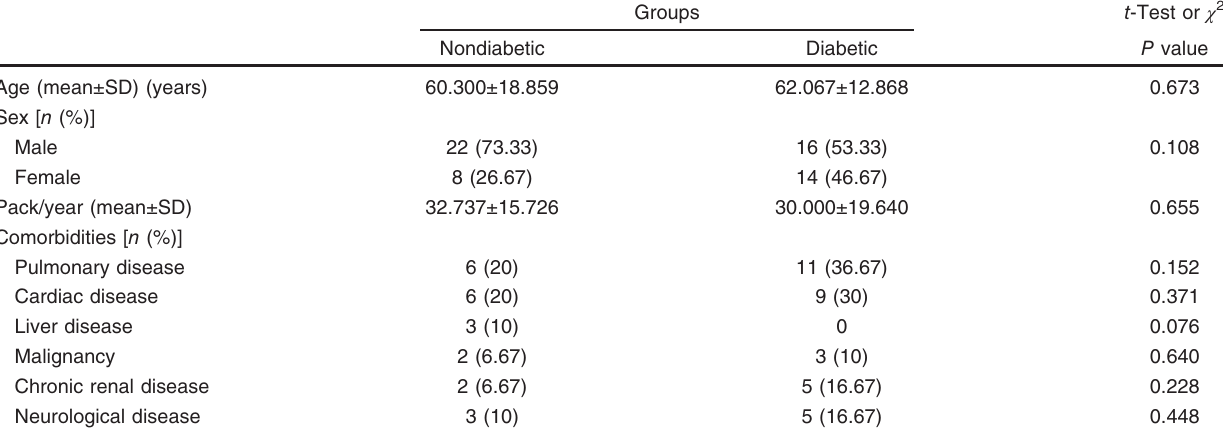
Table 1 Demographic data and comorbidities in both nondiabetic and diabetic patients